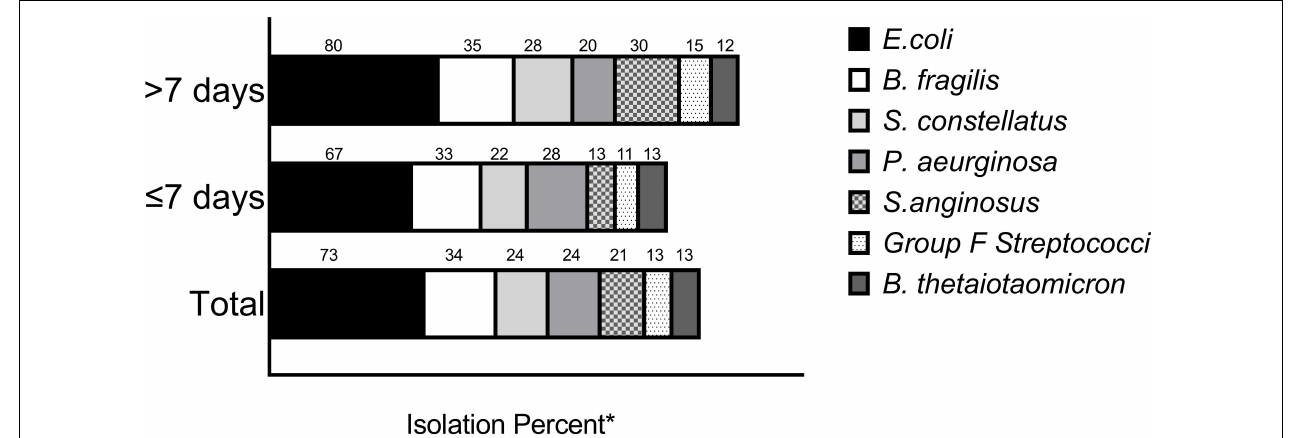
FIGURE 1 | Intraperitonal culture results. Shown (above the bars) are the percentages of the most common bacterial species isolated from intraperitoneal cultures by LOS cohort. *The numbers do not add up to 100 percent as many of the cultures were polymicrobial. TABLE 3 | Microbiologic and antibiotic treatment of patients by dichotomized LOS. Total LOS ≤ 7 days LOS > 7 days p-